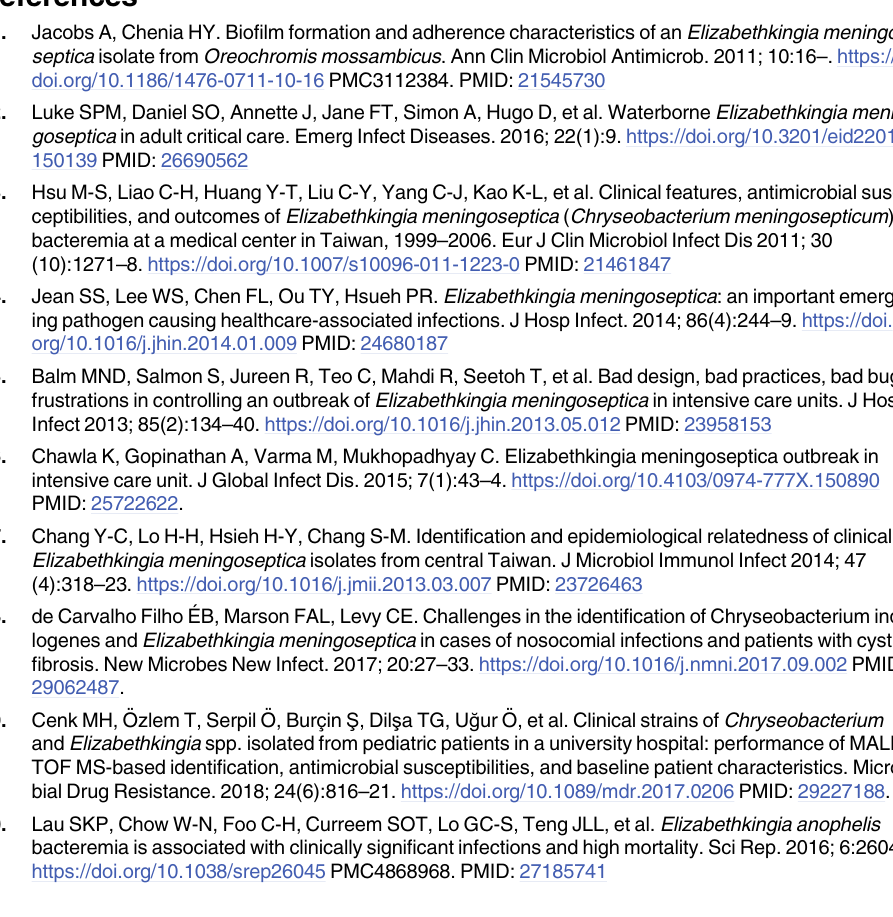
S6 Table. PHAST in Elizabethkingia